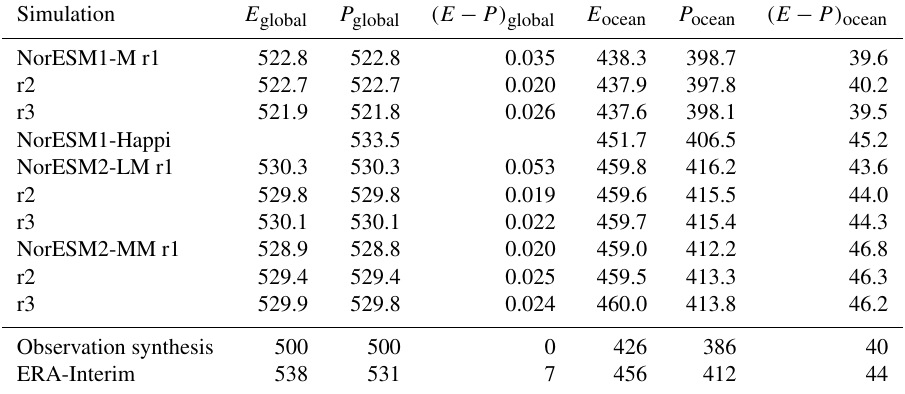
Table 5. Evaporation ( E ) and precipitation ( P ) for different historical NorESM simulations and reference datasets. Units are in thousands of cubic kilometres of water per year. The years used are 1980–2009, except for NorESM1-Happi (1976–2005) which is from Graff et al. (2019), and the last two lines (2002–2008) which are from Trenberth et al.